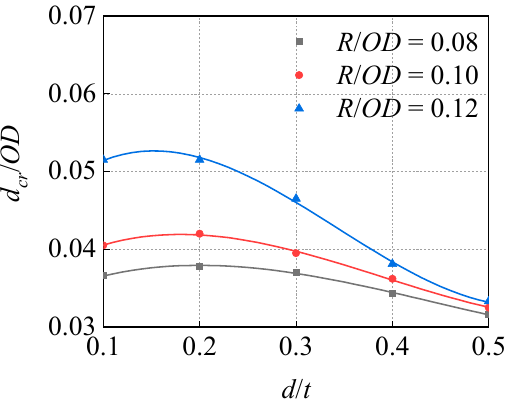
Figure 16. Influence of corrosion depth on critical dent depth under indenters with different curvature radii ( P = 10 MPa).